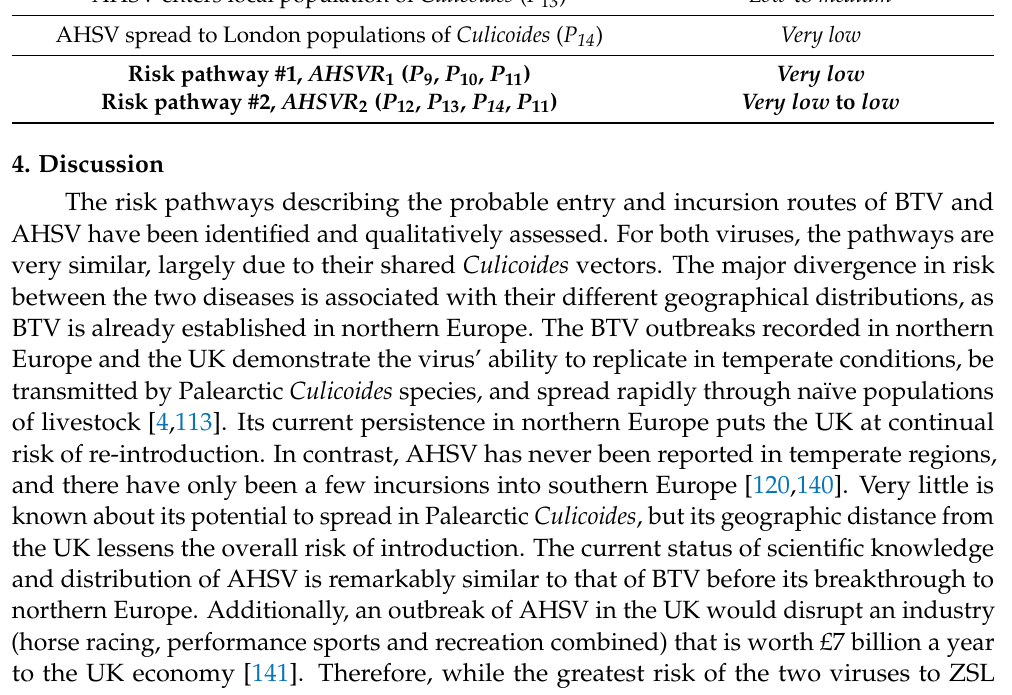
Table 5. Qualitative probability estimates for AHSV risk parameters and pathways during the vector active season. Probability Qualitative Probability AHSV-infected animal enters the zoo ( P 9 ) Very low AHSV enters zoo population of Culicoides ( P 10 ) Medium Resident zoo animal infected with AHSV ( P 11 ) Medium AHSV-infected equid enters the UK ( P 12 ) Very low AHSV enters local population of Culicoides ( P 13 ) Low to medium AHSV spread to London populations of Culicoides ( P 14